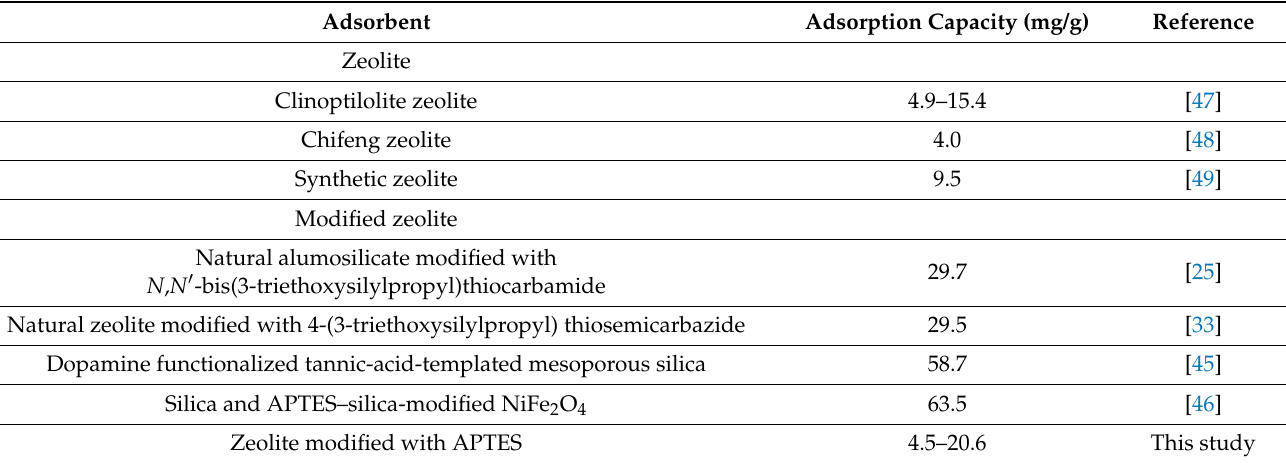
Table 7. Comparison of the adsorption capacities of modified zeolite with some other adsorbents for Cu(II)